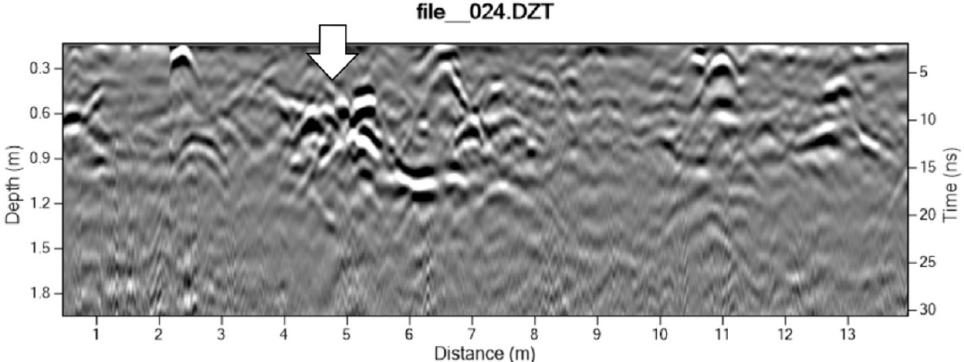
Figure 24. Perpendicular transect crossing of wall at Presidio San Francisco.